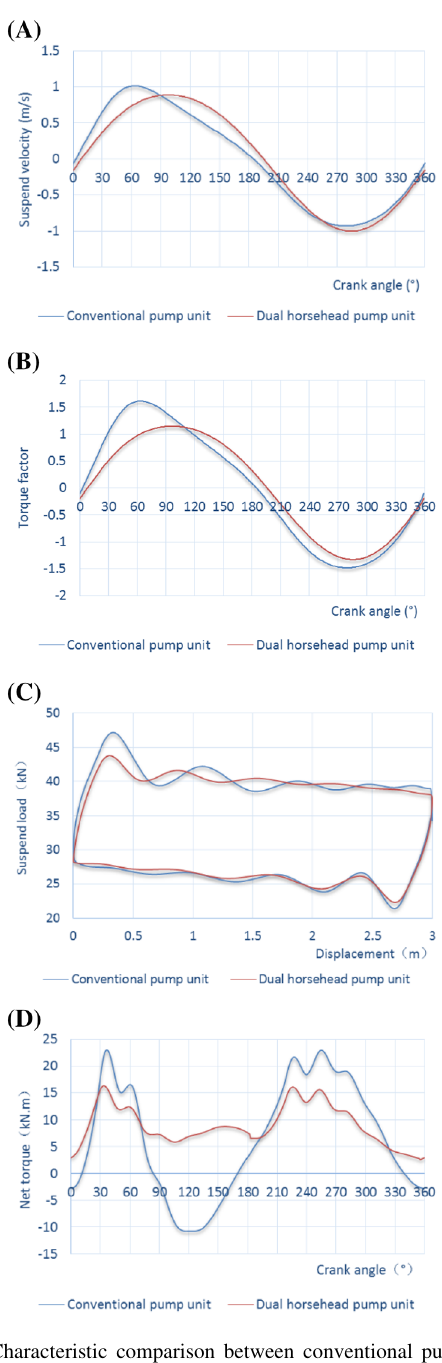
Fig. 9 Characteristic comparison between conventional pump units and dual-horsehead pump units (Liu and Feng 2014). a Suspend velocity, b torque factor, c polished rod indicator diagram, d net